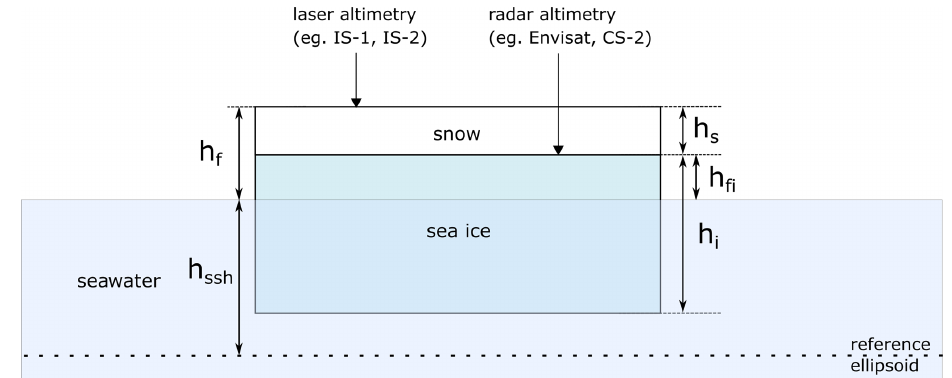
Figure 4. Schematic of sea ice floe, floating in hydrostatic equilibrium, and discussed variables.